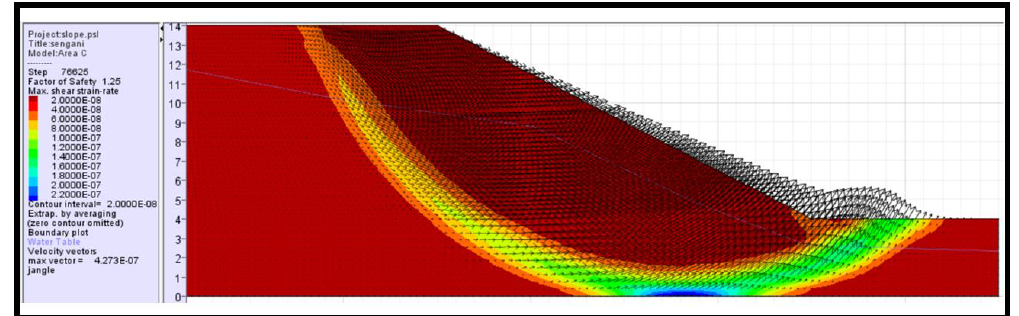
Figure 34. Simulated FoS of the clay loam soil slope using FLACSlope in rainy conditions with a water table with 2500 m 3 volume of water. Note that maximum shear strain simulated ranges between 2.00 × 10 −8 to 2.273 × 10 − 7 .